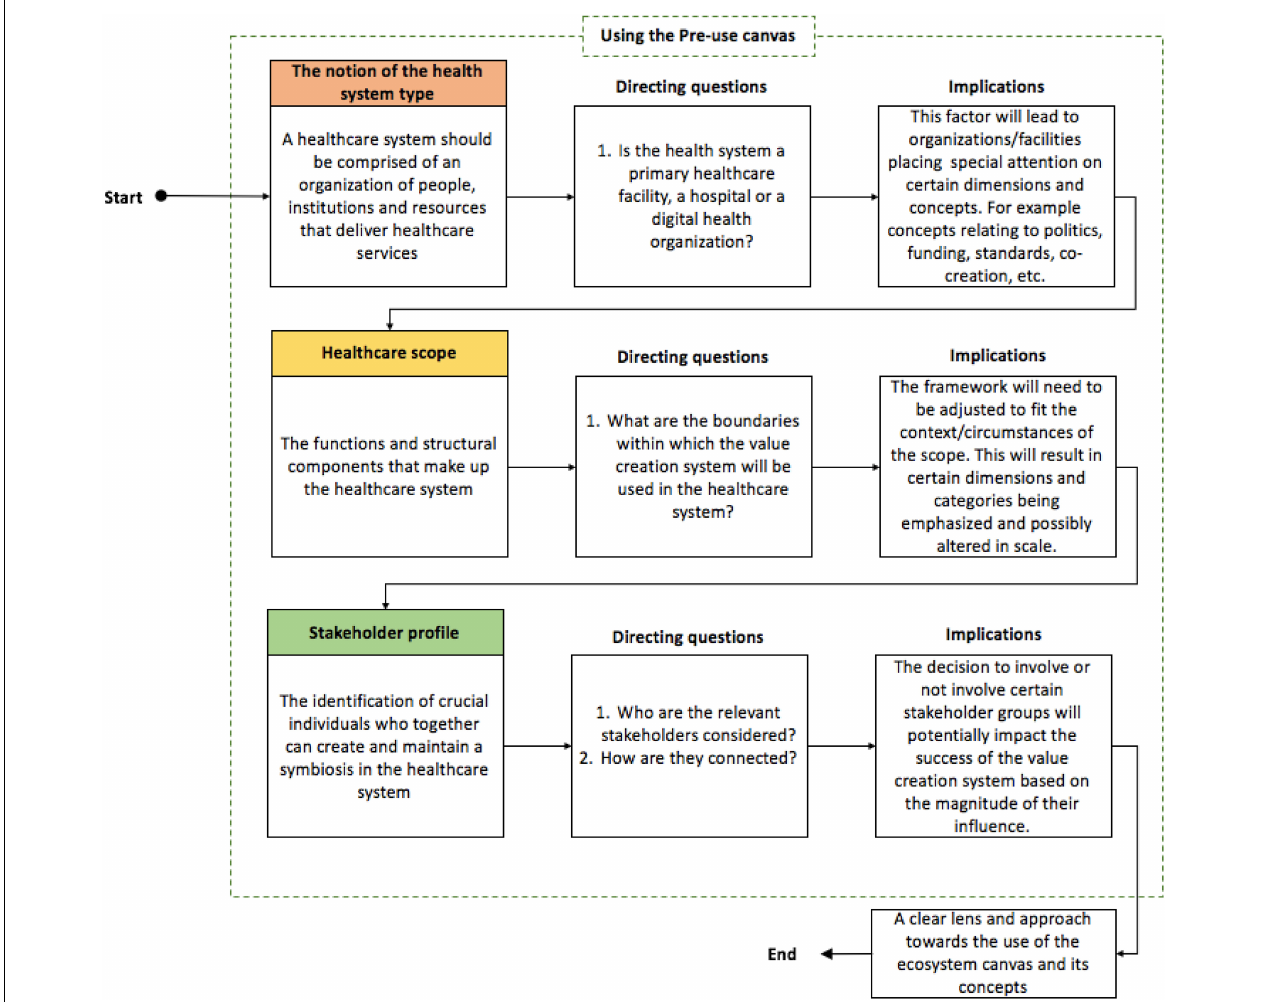
FIGURE 9 | The pre-use canvas of the final management